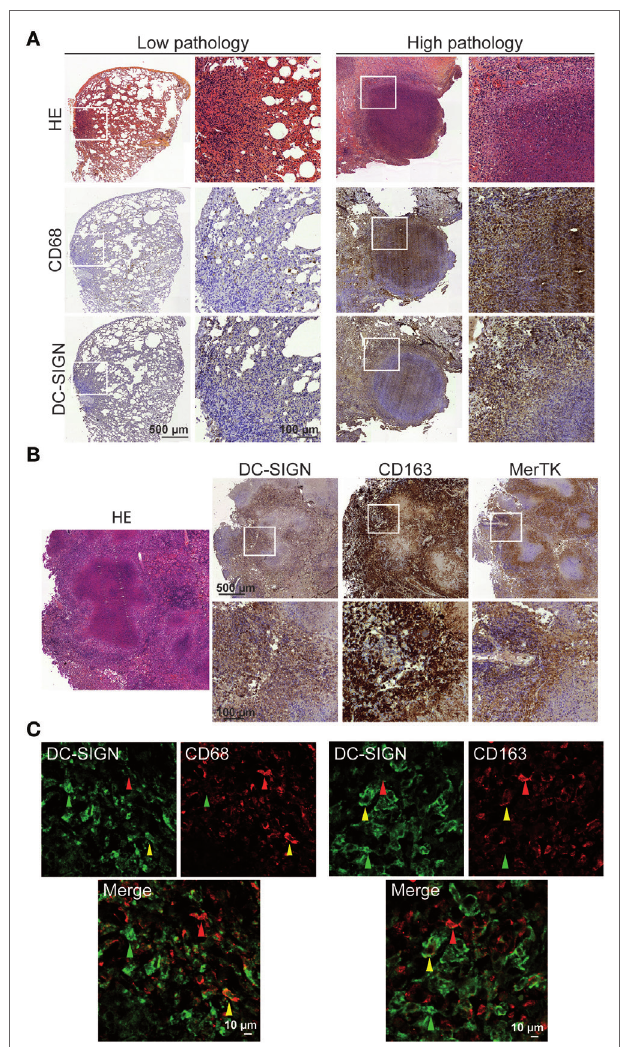
FigUre 1 | DC-SIGN-expressing macrophages are present in pulmonary lesions of non-human primates (NHP) infected with Mtb. (a) Representative immunohistochemical images illustrating the distribution of CD68 (middle row) and DC-SIGN (bottom row), among areas where leukocyte infiltration (top row) is detected by hematoxylin and eosin (HE), in pulmonary tissue and granulomas of NHP with very mild (left columns) and severe (right columns) pathology. (B) Representative immunohistochemical images illustrating the distribution of DC-SIGN, CD163, and MerTK in areas where leukocyte infiltration is detected by HE, such as in granulomas of NHP with severe pathology. (c) Left panel : immunostaining of DC-SIGN (green: Alexa-488) and CD68 (red: Alexa-555) in lung tissue of NHP with severe pathology; right panel : immunostaining of DC-SIGN (green: Alexa-488) and CD163 (red: Alexa-555) in lung tissue of NHP with severe pathology. Green arrow points out a cell positive for DC-SIGN only; red arrow a cell positive for CD68 or CD163 only; and yellow arrow for a cell positive for both DC-SIGN and CD68/CD163. Scale bar = 10